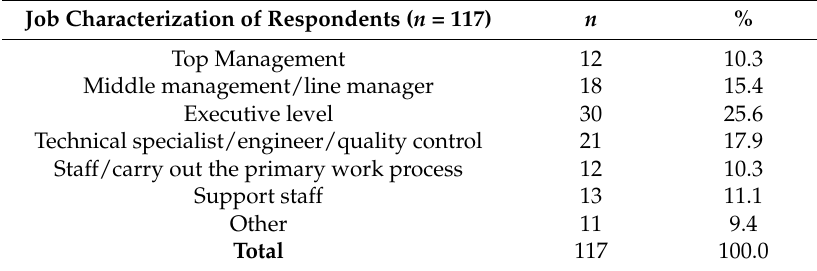
Table 4. Background information on students that participated in the study—Job.